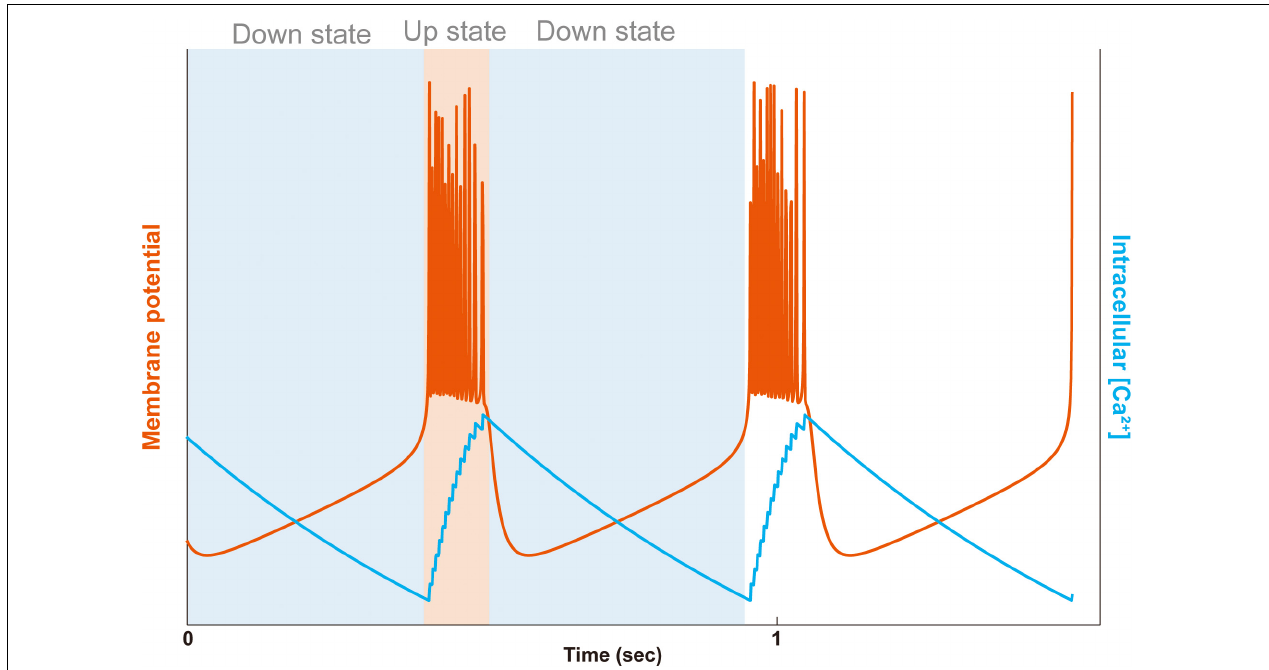
FIGURE 2 | Bursting and intracellular Ca 2 + concentration in a simple model. The membrane potential (orange line) and the intracellular Ca 2 + concentration (blue line) are plotted. The bursting consists of UP and DOWN states alternating with each other. In the DOWN state (light blue background), the membrane potential is hyperpolarized to be quiet, and in the UP state (light orange background), the membrane potential is depolarized to generate a series of fast action potentials. In the first DOWN state, deactivation of the Ca 2 + -dependent potassium outward current ( I K [ Ca ] ) raise the membrane potential toward the threshold of Na + and K + dependent fast action potentials ( I Na / K ), entering the UP state. In the UP state, the fast Na + spikes also activate high-threshold Ca 2 + current ( I Ca ), building up the intracellular Ca 2 + concentration. At the end of the UP state, due to the activation of the Ca 2 + -dependent potassium current ( I K [ Ca ] ), the membrane potential repolarizes, going to the DOWN state. In the second DOWN state, the hyperpolarized membrane then deactivates the I K [ Ca ] to evoke another raise of membrane potential. The plot was calculated by the simplified-average neuron (SAN) model with arbitrary y -axis scales for visual aid (Yoshida et al.,